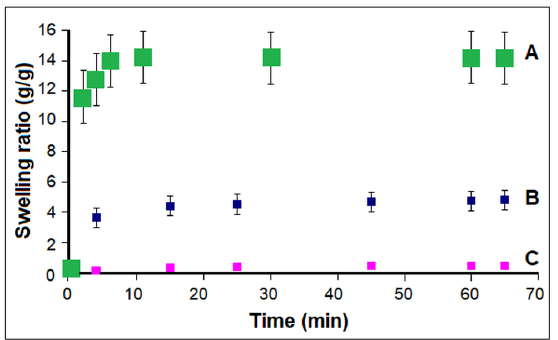
Figure 3. Swelling behavior: effect of the synthesis conditions for the CP7 sample (Entry 2, Table 1) obtained at different temperatures and feed concentrations: (A) − 12 °C, c—2.4%; (B) − 12 °C, c— 1.25%; (C) 37 °C, c—1.25%.